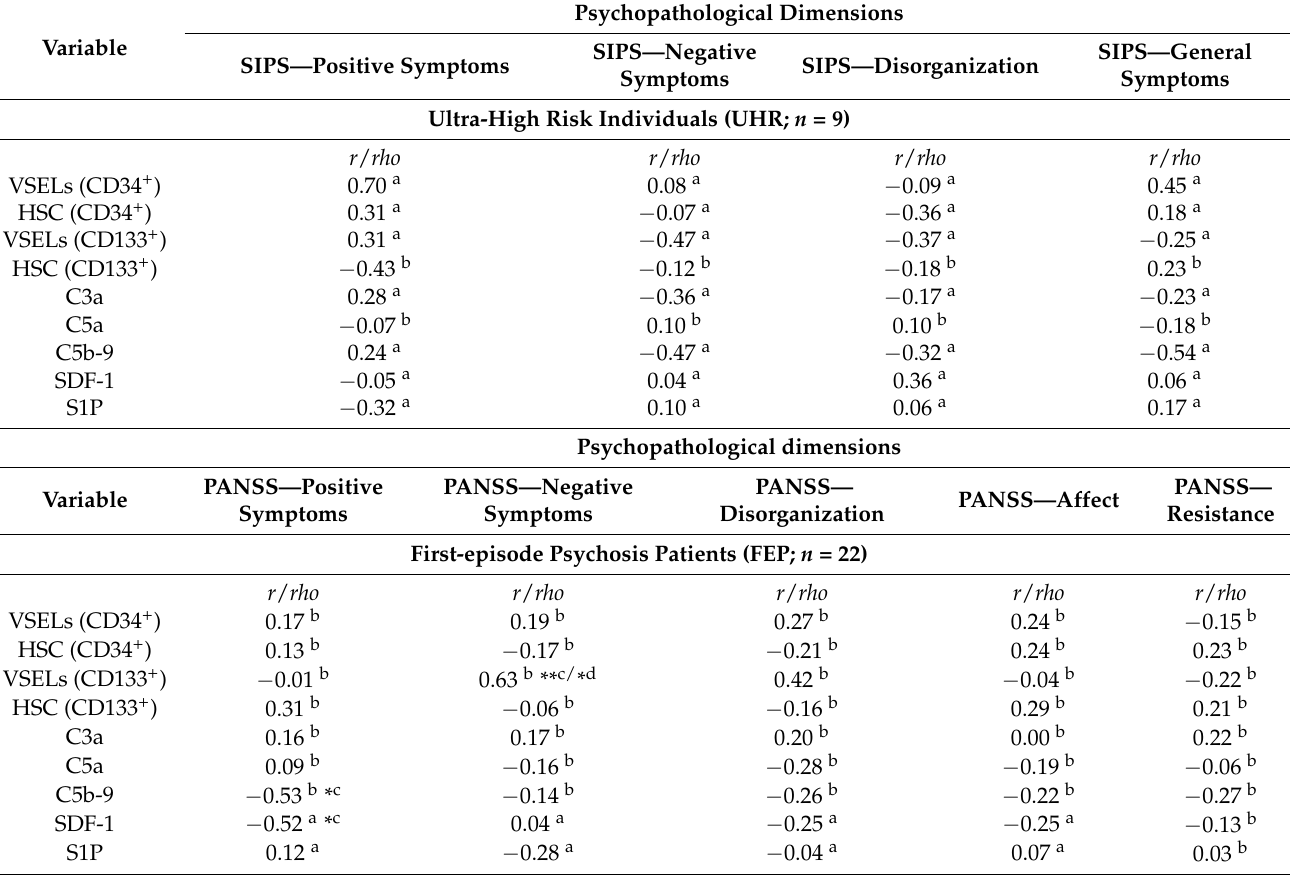
Table 3. Relationship between biological parameters and psychopathological dimensions in the two clinical